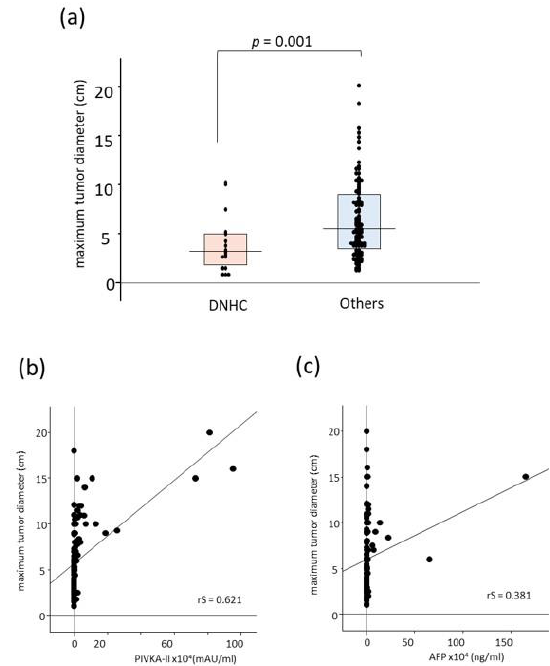
Figure 3. The difference in the maximum tumor diameter and correlation with tumor markers in higher-stage HCCs. ( a ) The median maximum tumor diameter of DNHC was smaller than the other tumors [3.2 (1.8 – 5.0) vs. 5.5 (3.5 – 9.0) cm, respectively, p = 0.001]. Tumor size was moderately corre- lated with ( b ) DCP levels (rS = 0.621) rather than ( c ) AFP (rS = 0.381). AFP, alpha-fetoprotein; DCP, des-gamma-carboxyprothrombin; DNHC, double negative HCC; HCC, hepatocellular carcinoma.